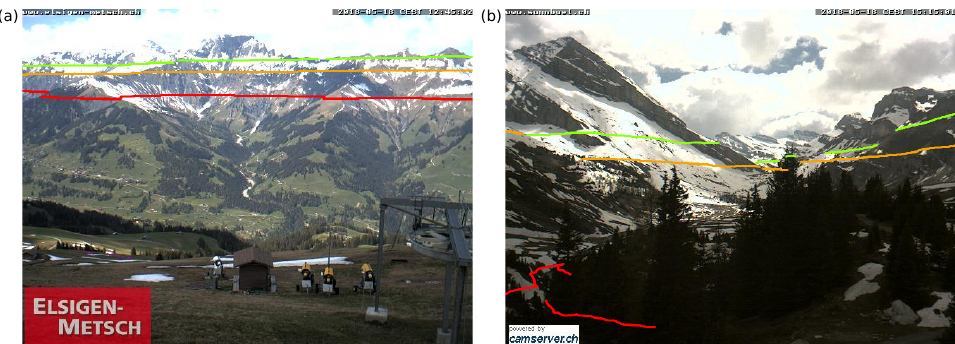
Figure 10. Differences in regional snow-line elevation (RSLE) shown on images of the webcams ( a ) Frutigen Metschalp (© elsigen-metsch.ch (accessed on 24 March 2021)) and ( b ) Kandersteg Sunnbüel (© www.sunnbuel.ch (accessed on 24 March 2021)). RSLE is marked in red (webcams), orange (MOYD product with NDSI 0.1), and green (MOYD product with NDSI